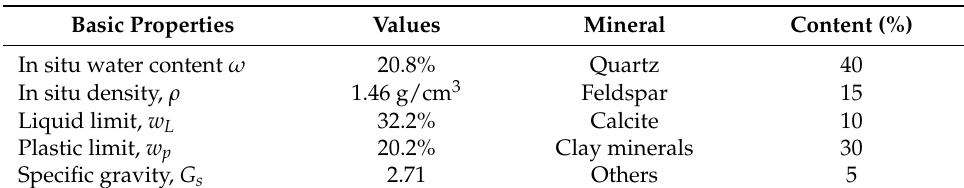
Table 1. Basic properties and mineral composition of studied loess.